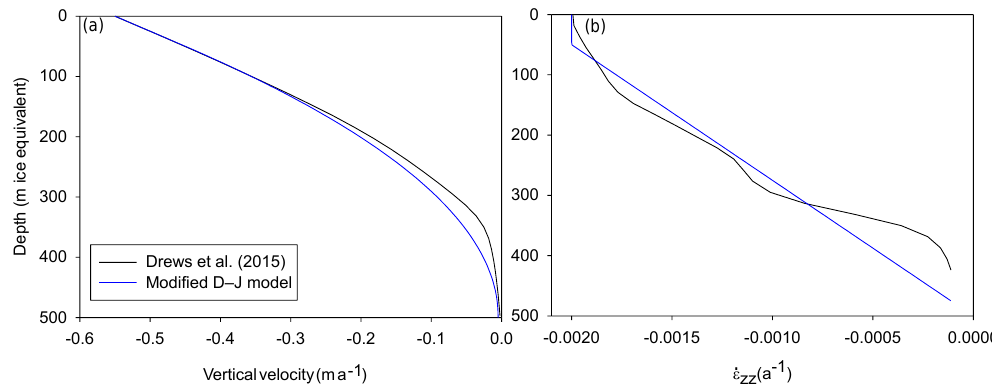
Figure 2. (a) Vertical velocity profiles and (b) vertical strain-rate profiles according to the modified Dansgaard–Johnsen model (blue) and the full Stokes model (black; Drews et al.,